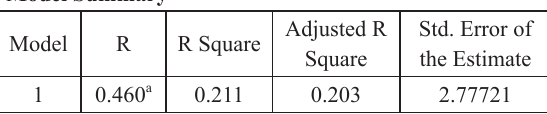
Model Summary for Existing Culture.